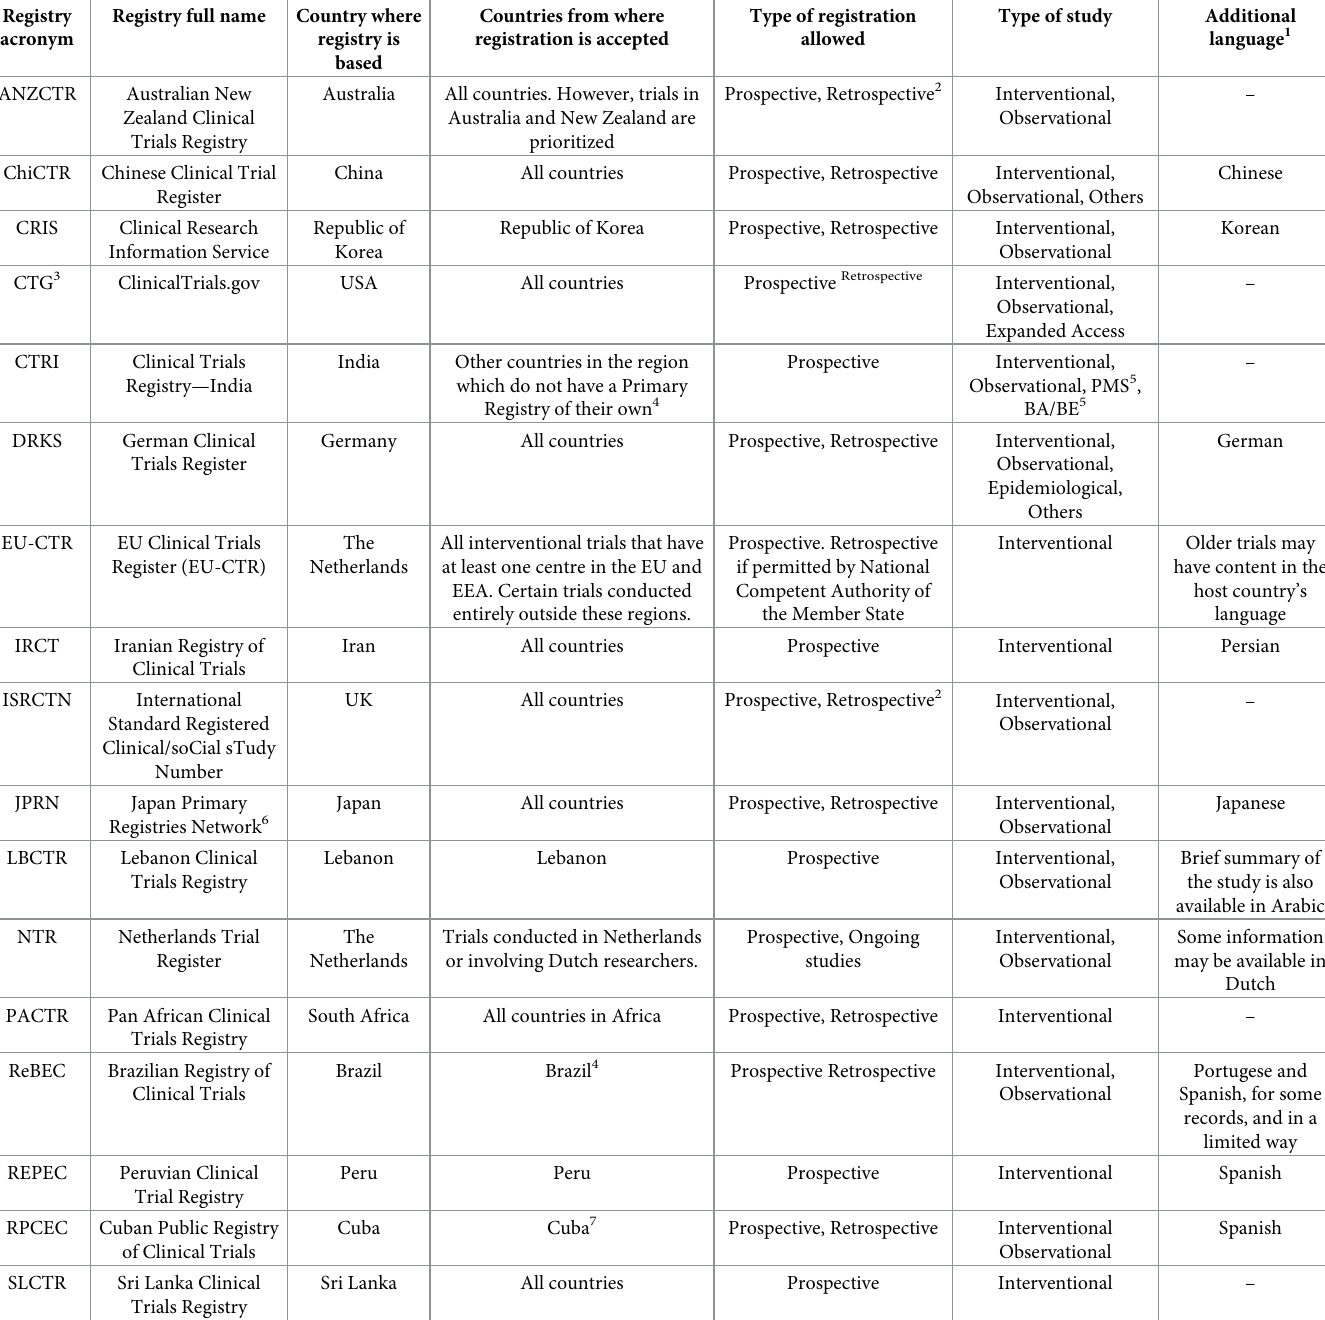
Table 2. An overview of each registry, listing its acronym, full name, country where it is based, countries from where registration is accepted, type of registration allowed, type of study hosted, and language